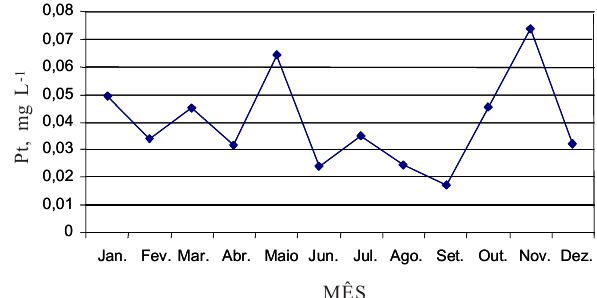
Figura 1. Resultado da simulação matemática do cenário A, no ano de 2006, para a concentração mensal de P total (Pt) no reservatório Piraquara